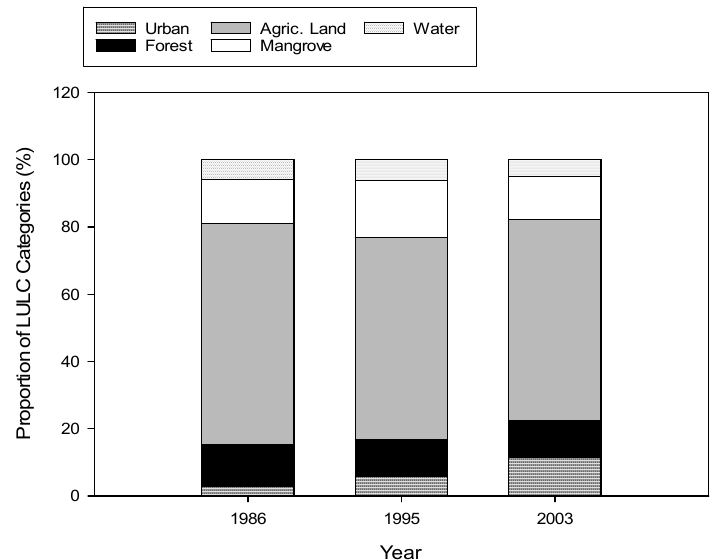
Figure 9. Stacked bar chart used for comparing the proportions of all the LULC categories. Generally, the bar chat shows that the study area experienced an incremental growth in urban area and a decline in agricultural